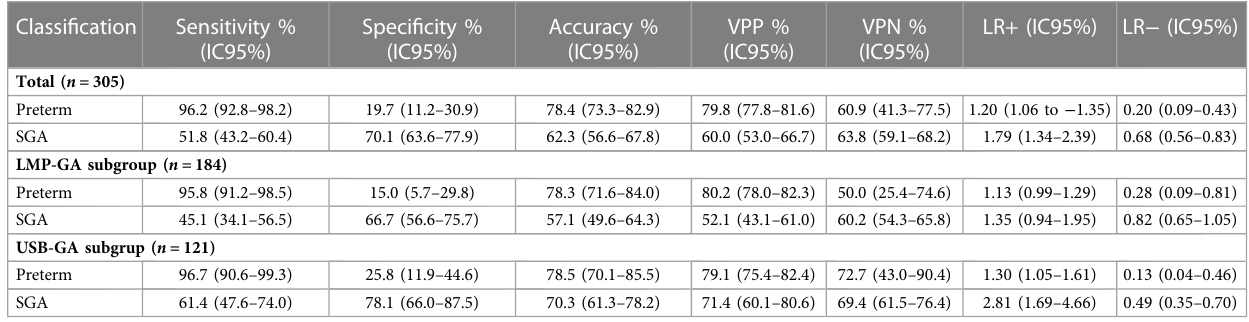
TABLE 3 Accuracy of the classi fi cation of low-birth-weight newborns as premature and small for gestational age. Classi fi